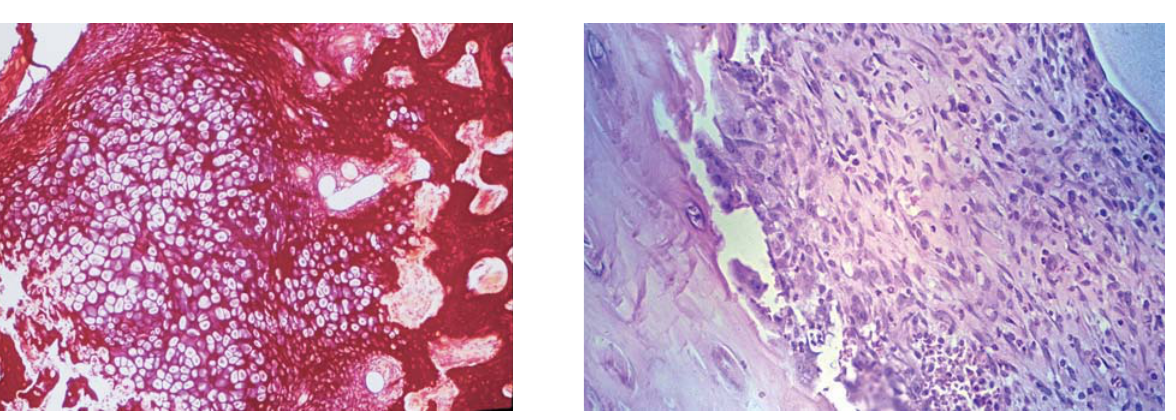
FIGURE 3- 15 days – RC group. Reparative cartilage formation and substitution by bone matrix (P.S., original magnification, x100)